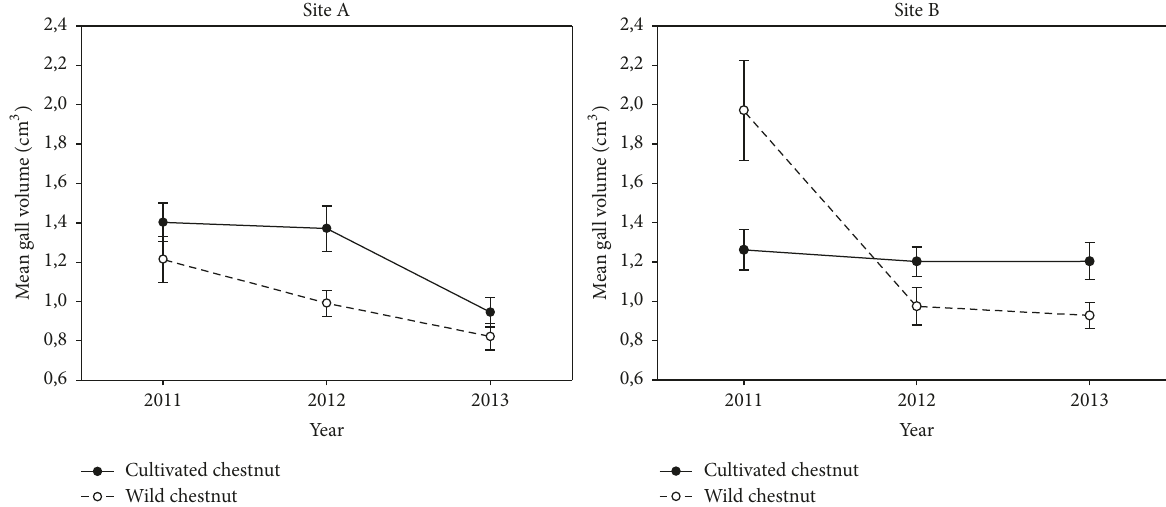
Figure 1: Dryocosmus kuriphilus gall size. Samples collected from cultivated and wild chestnuts in the two study sites (site A = 478 m a.s.l.; site B = 665 m a.s.l.) at Marradi (Italy) during the three-year period. Bars represent standard